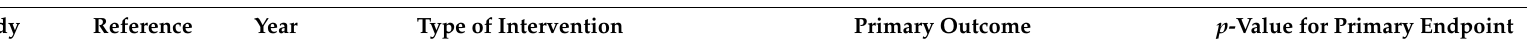
Table 2. Cont. Extra Virgin Olive